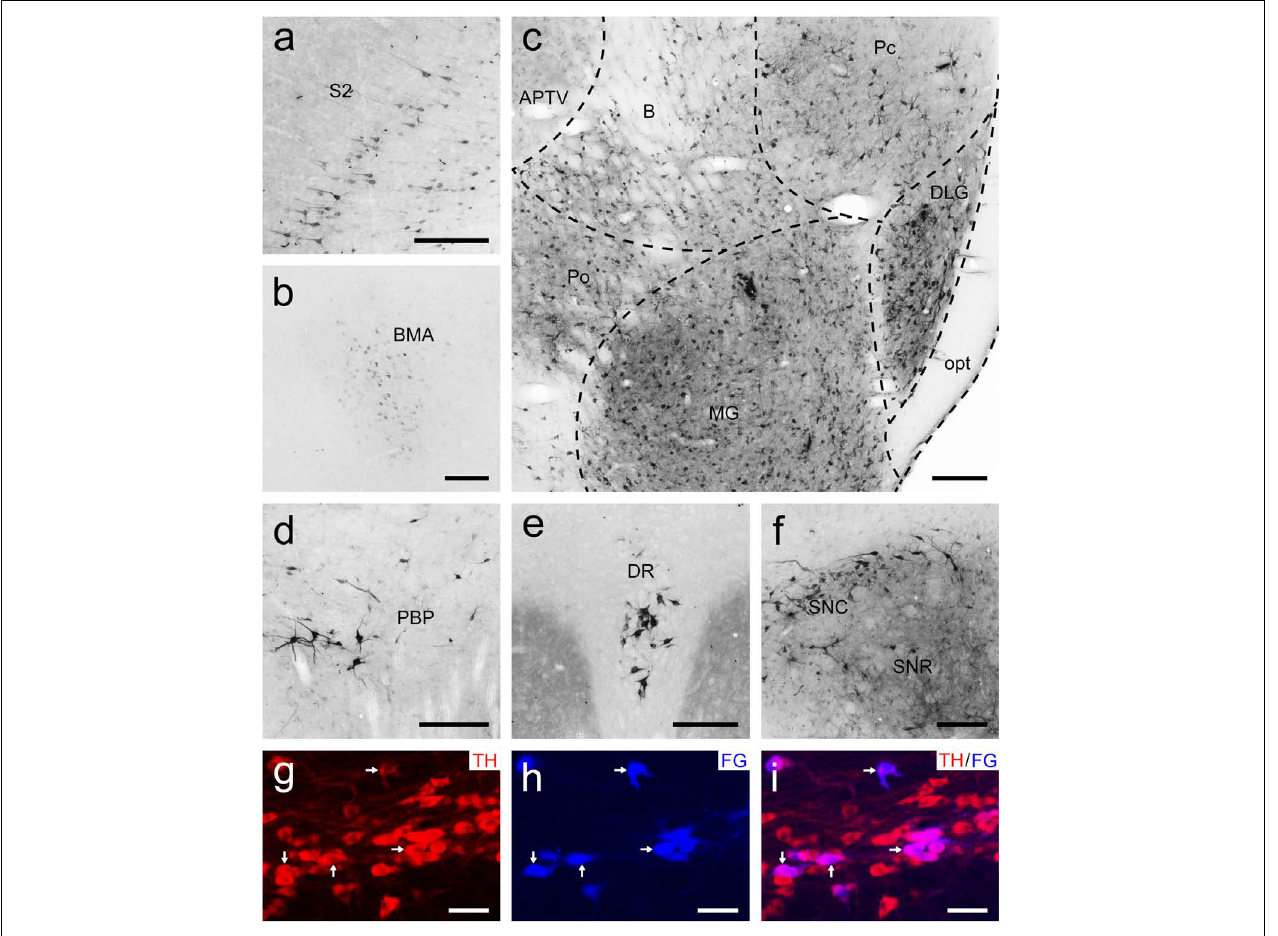
FIGURE 8 | Bright-field photomicrographs showing the distribution of FG-labeled neurons projecting to the putamen (Pu) in the secondary somatosensory cortex (S2; a ), basomedial amygdaloid nucleus (BMA; b ), thalamus (c) , parabrachial pigmented nucleus of the ventral tegmental area (PBP; d ), dorsal raphe nucleus (DR; e ), and substantia nigra (f) . The dashed line marks the boundaries between brain regions (c) . (g–i) Double labeling with anti-tyrosine hydroxylase antibody (TH, red) and FG (blue) in the compact part of the substantia nigra (SNC). The arrows show the double-labeled cells. Scale bars = 200 µ m in (a–f) ; 100 µ m in (g–i)